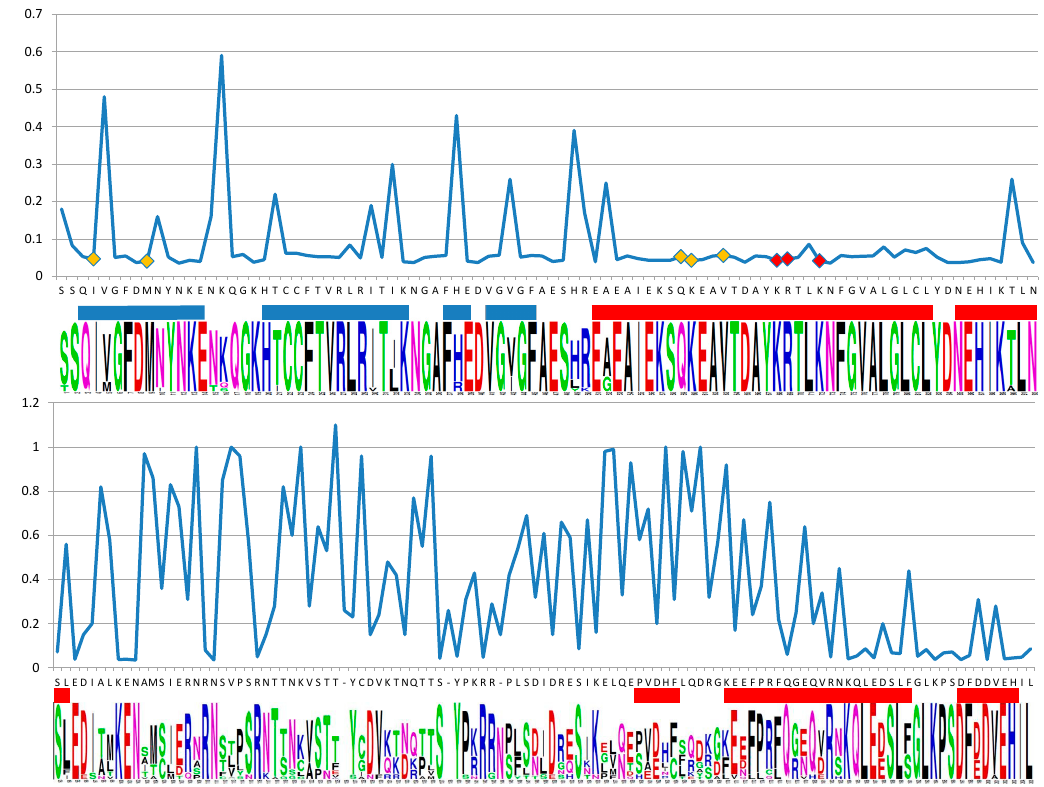
Figure 3. Point value of Ka/Ks ratio along amino acidic sequence indicated by the web-logo graphics. Values gained under the M8 model. Amino acid participating in a β -sheet formation are underlined in blue, while α -helix are underlined in red. All the five AA (I4, M9, Q59, K60, and V63) predicted as DNA binding by I-Tasser are evidenced by a yellow square on the diagram. Residues evidenced by a red square on the diagram are those predicted as DNA binding sites by Kagawa [25] (K129, R130, and R133)